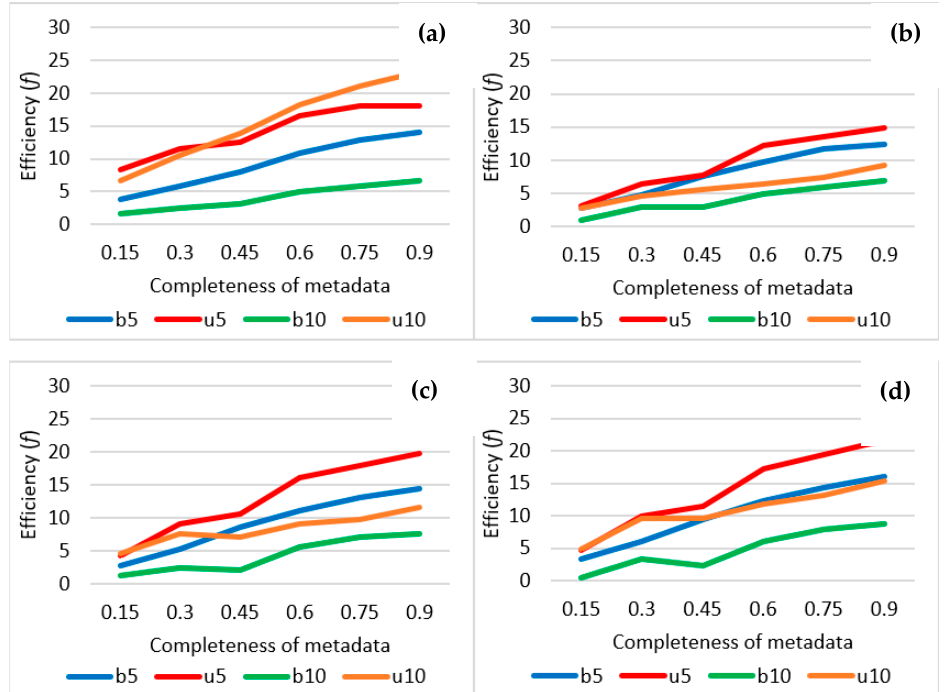
Figure 7. The same as Figure 4, but here the efficiencies are shown in the function of the metadata completeness. Upper left panel ( a ) CRMSEm, upper right panel ( b ) CRMSEy, bottom left panel ( c ) Trend bias for individual time series (Trbias), bottom right panel ( d ) Network mean trend bias (Trnetb).